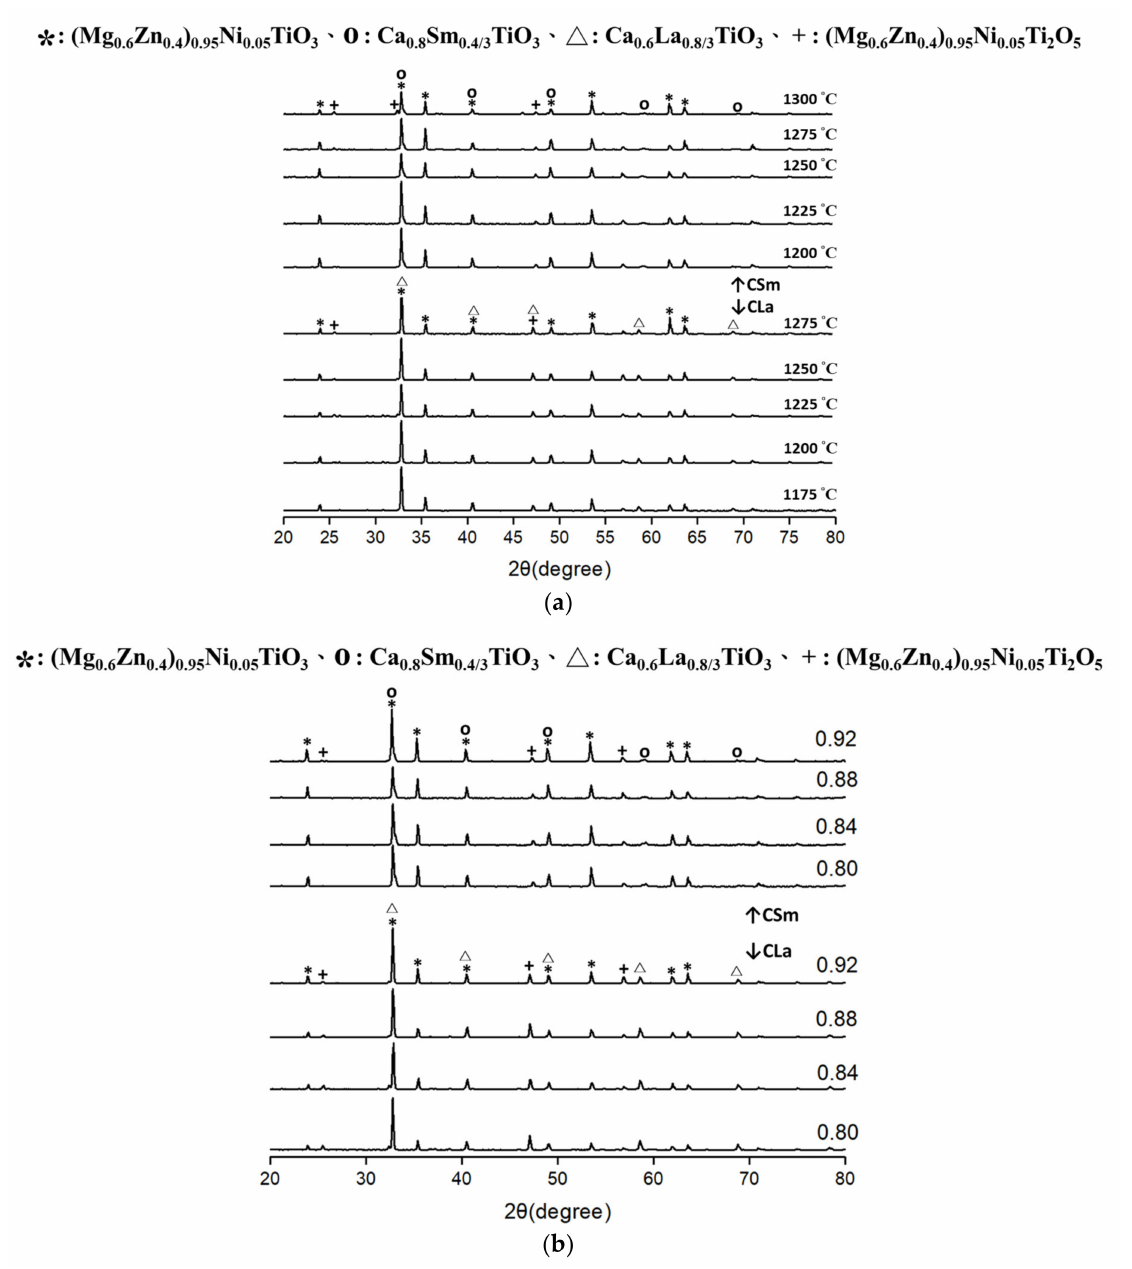
Figure 1. X-ray diffraction illustrations of ( a ) 0.88(Mg 0.6 Zn 0.4 ) 0.95 Ni 0.05 TiO 3 -0.12 Ca 0.6 La 0.8/3 TiO 3 /Ca 0.8 Sm 0.4/3 TiO 3 ceramics sintered at various temperatures for 4 h, ( b ) x(Mg 0.6 Zn 0.4 ) 0.95 Ni 0.05 TiO 3 -(1 − x)Ca 0.6 La 0.8/3 TiO 3 sintered at 1225 ◦ C for 4 h /Ca 0.8 Sm 0.4/3 TiO 3 sintered at 1250 ◦ C for 4 h with various x